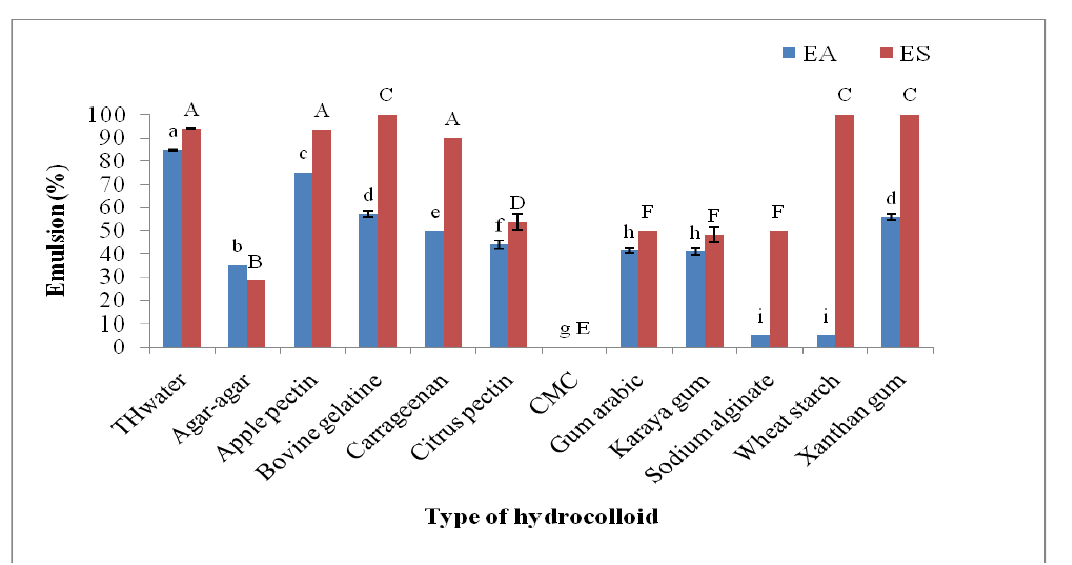
Figure 2. Emulsifying activity (EA) and emulsion stability (ES) of tamarillo and commercial